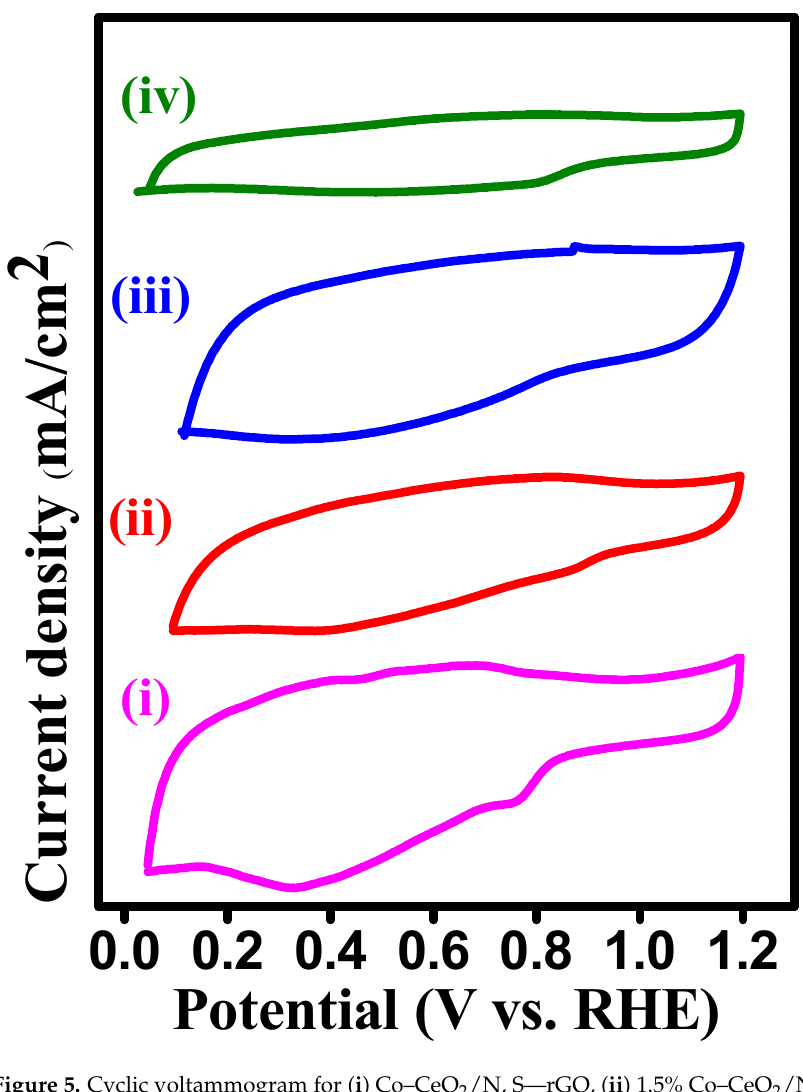
Figure 5. Cyclic voltammogram for ( i ) Co–CeO 2 /N, S–-rGO, ( ii ) 1.5% Co–CeO 2 /N, S–rGO, ( iii ) 3%